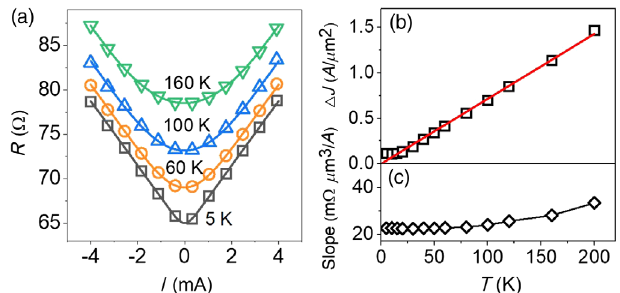
FIG. 4. (a) Symbols: resistance vs current for a 1 - μ m-long, 500-nm-wide Au(5) wire on Si substrate, at the labeled values of temperature. Curves: results of the data fitting with a linear function R ð I Þ ¼ R ð 0 Þ þ α j I j convolved with the Gaussian. (b),(c) Parameters extracted from the data fitting: the Gaussian width Δ I (b) and the slope of the linear dependence (c). The line in (b) is the best linear fit of the data for T > 20